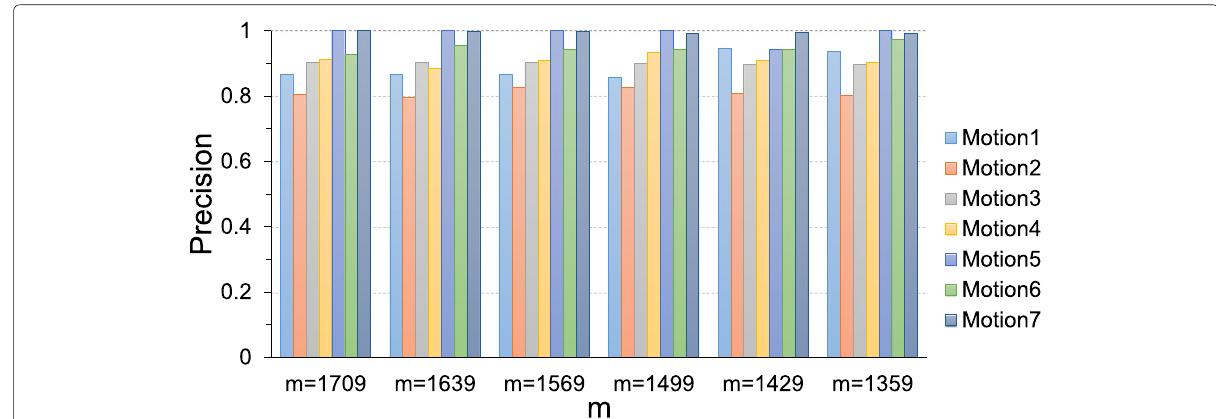
Fig. 7 The impact of m on the precision of PLF-RKDR algorithm on the real